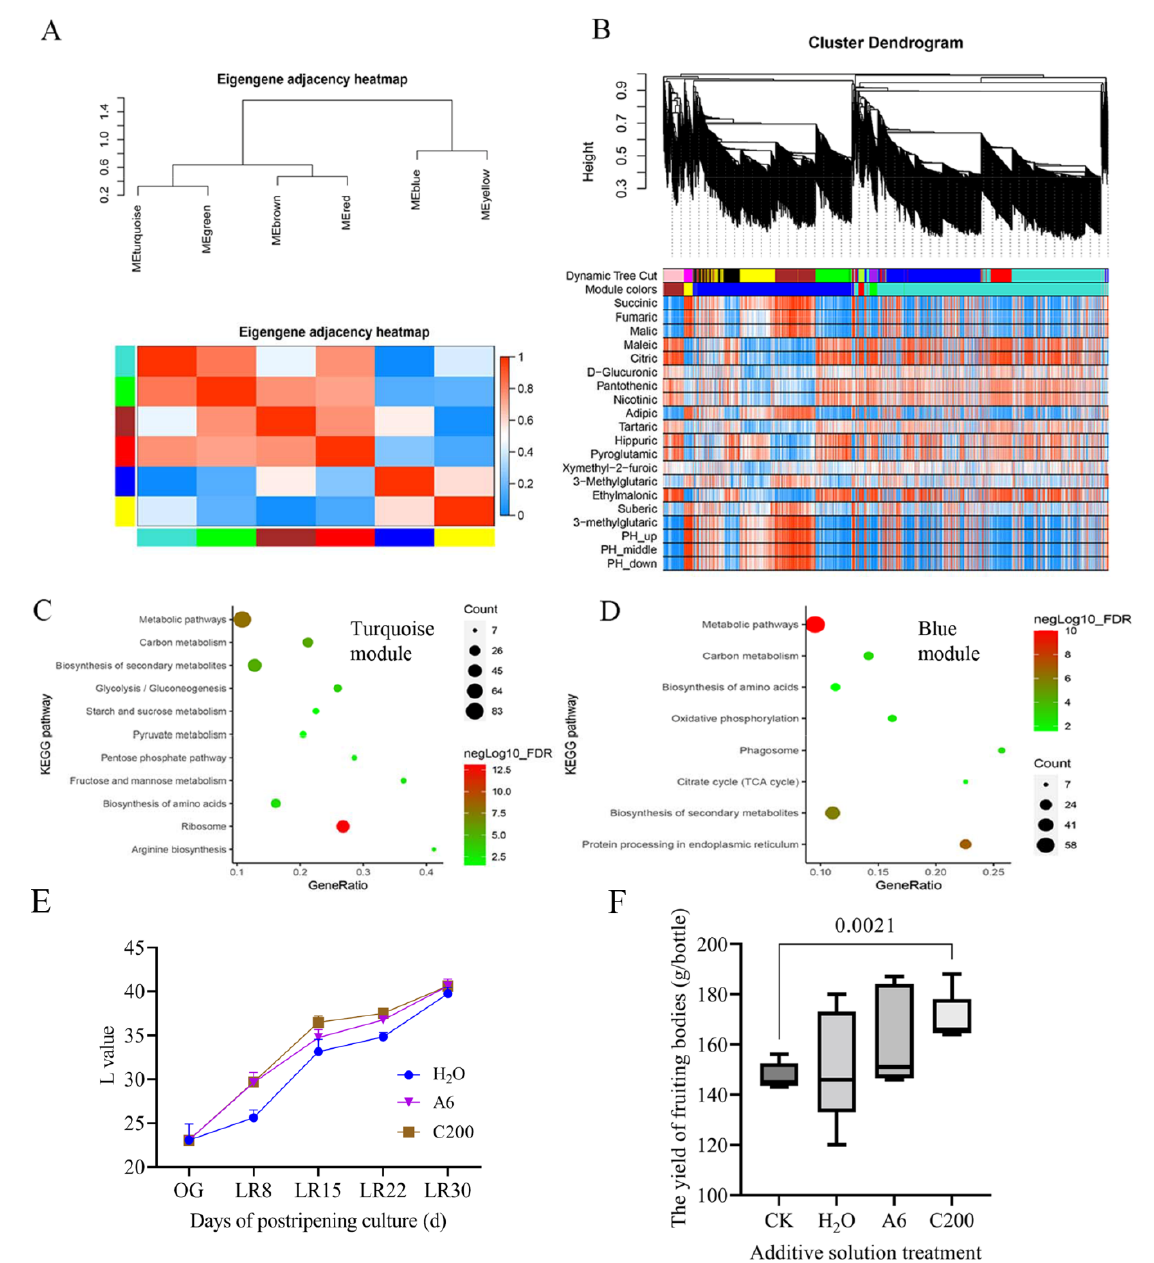
Figure 6. Cultivation experiment with arginine and citric acid addition. ( A ) Clustering dendrograms of module eigengenes and heatmap of eigengene adjacency. Each row and column corresponds to one eigengene within the heatmap. Red indicates high adjacency (positive correlation) within the heatmap, and turquoise indicates low adjacency (negative correlation), as shown by the color legend. ( B ) Hierarchical cluster dendrogram showing coexpressed modules and module trait heatmap. Each leaf on the tree represents a gene. Each colored row indicates a color-coded module that contains a group of highly interconnected genes. ( C ) The KEGG enrichment of genes in turquoise modules. ( D ) The KEGG enrichment of genes in blue modules. ( E ) Change in the L-value of wood chips in the postripening culture under different treatments; H 2 O represents 10 mL H 2 O solution. A6 represents 10 mL arginine solution with 6 mmol/L; C200 represents 10 mL citrate solution with 200 mg/L. ( F ) Statistics of fruiting body yield per bottle in the postripening culture under different treatments. CK represents the traditional postripening culture without any solution addition for 40 days. The illustrations of other treatments can be found in ( E